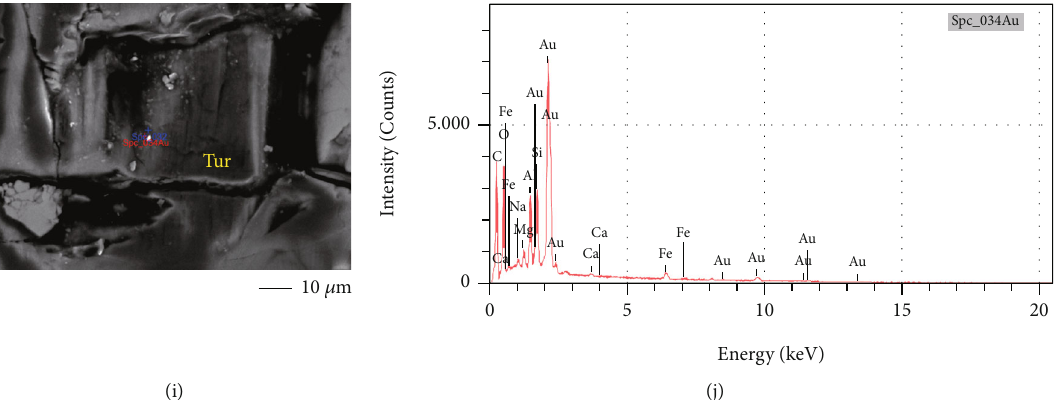
Figure 5: Electric scanning images and spectral images of Au-bearing and Ag-bearing minerals of Xinmin deposit. (a) Nature silver in the fi ssure of quartz. (b) Spectral image of silver in the quartz. (c) Sliver-bearing bismuthinite enclosed by chalcopyrite. (d) Spectral image of silver-bearing bismuthinite. (e) Silver, gold-bearing mineral in the tourmaline. (f) Spectral image of silver, gold-bearing mineral in the tourmaline. (g) Nature gold in the fi ssure of quartz. (h) Spectral image of gold in the quartz. (i) Nature gold in the tourmaline. (j) Spectral image of gold in the tourmaline. Mineral abbreviations (after [19]): Bm: bismuthinite; Ccp: chalcopyrite; Fl: fl uorite; Fsp: feldspar; Qz: quartz; Tur: